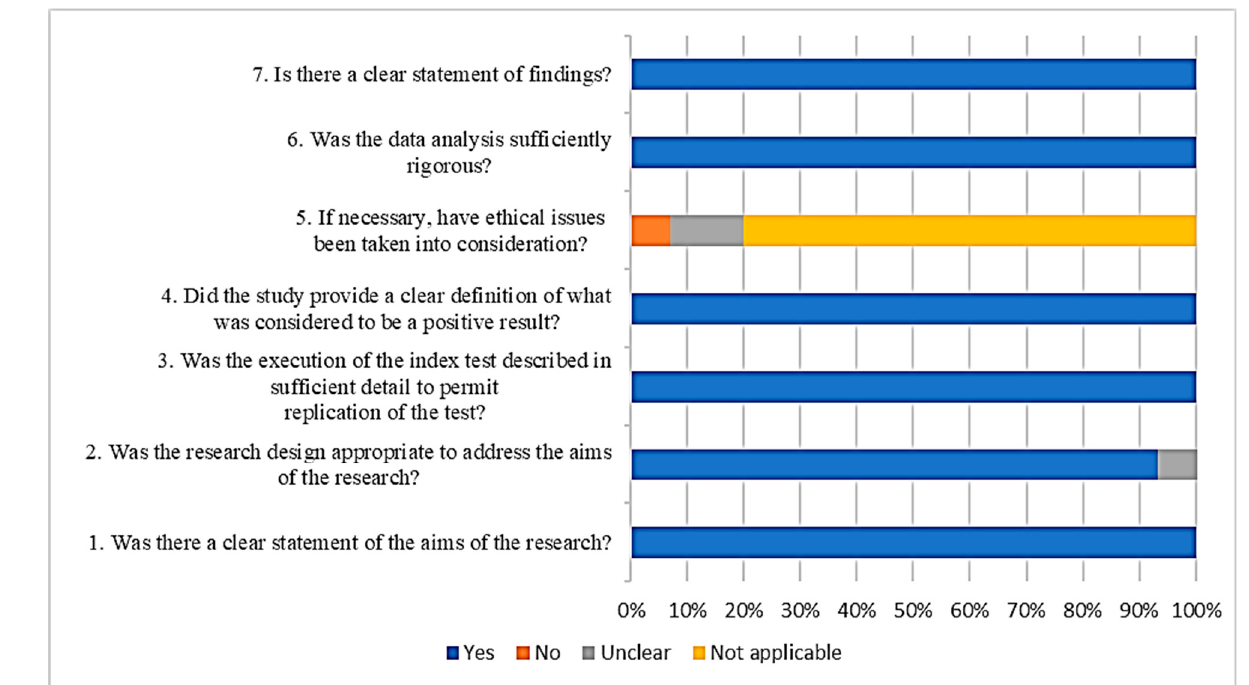
Figure 2. Quality assessment of the retrieved articles.